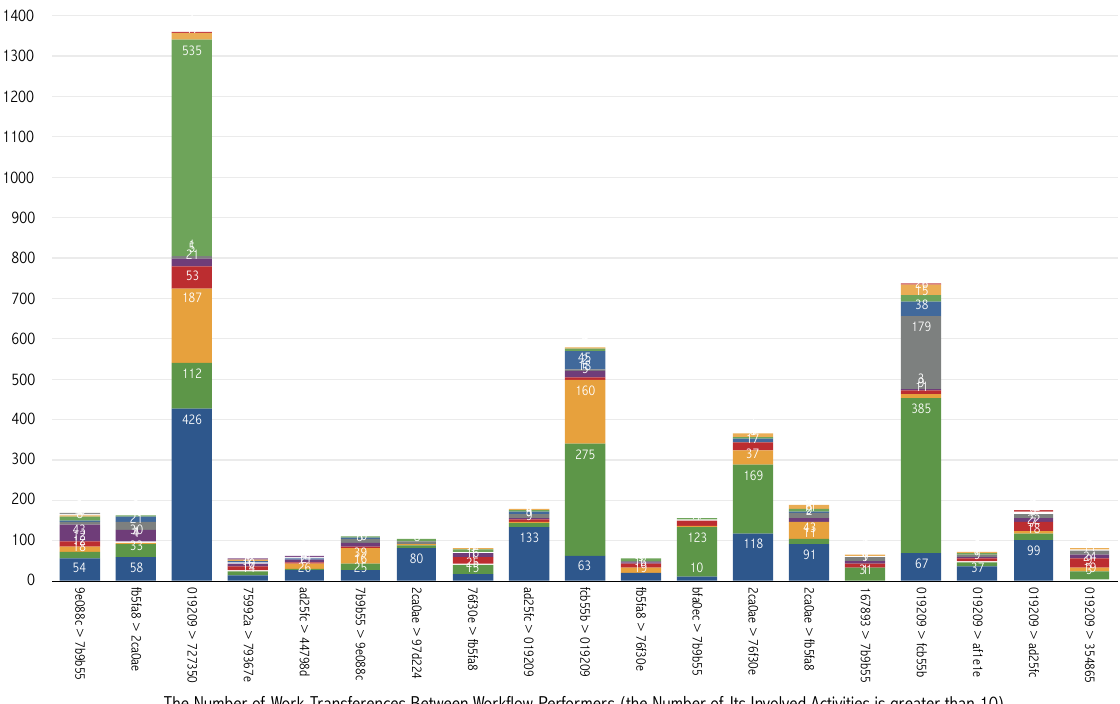
Figure 13. Performers with the number of transferring works to others (nine different involved activities).